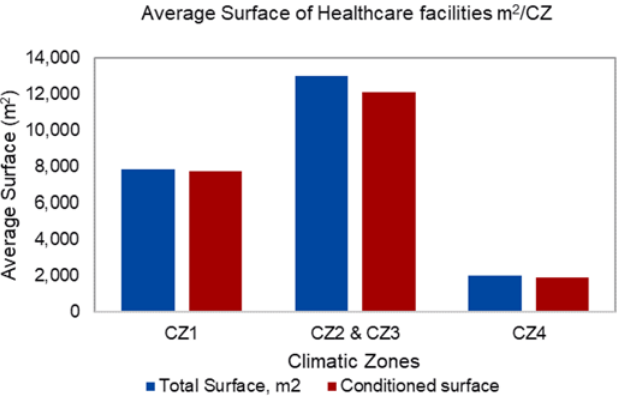
Fig. 3. Percentage of energy consumption per energy source in each climate zone.